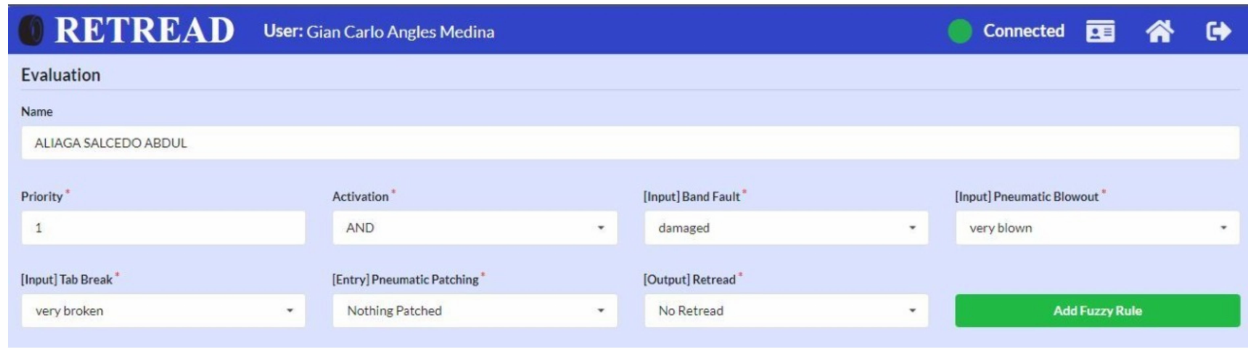
Figure 8. Edit the Fuzzy Rules